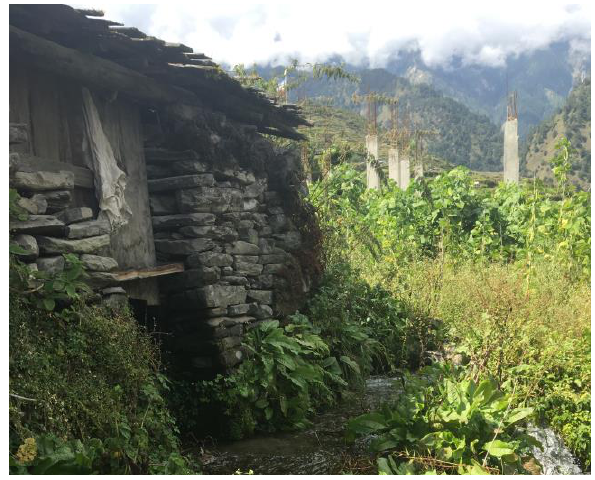
Figure 10. Downstream façade of a mill (Authors).